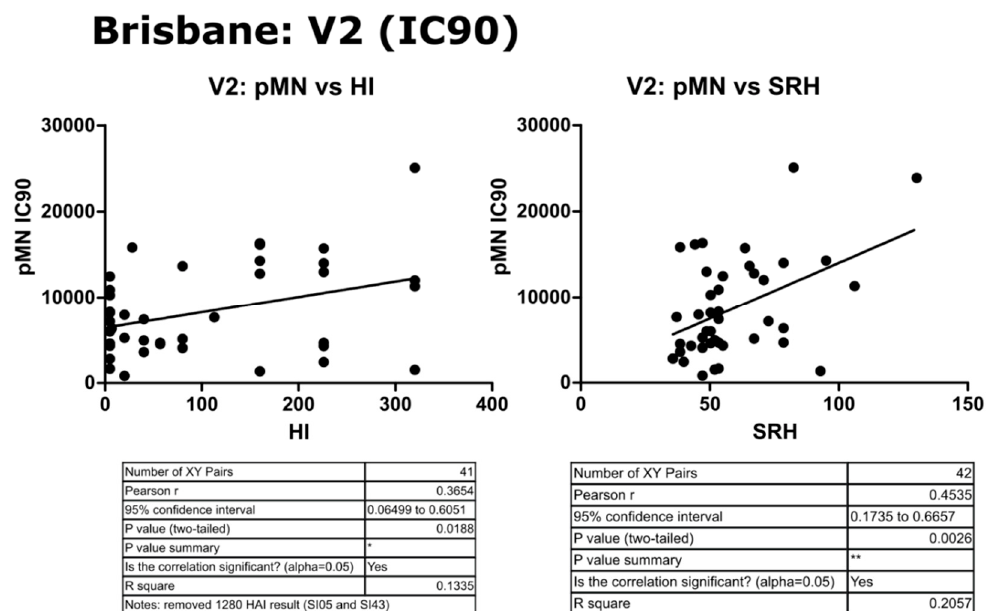
Figure 10. Correlation of pMN (IC 90 ) with HI and SRH using mean V2 values for sera assayed against B/Brisbane/60/2008 PV. Pearson’s two-tailed analysis performed using prism Graph Pad. Weak correlation was observed between IC 90 antibody titres and HI (Pearsons r = 0.36). IC 90 values correlated well with SRH values (Pearsons r = 0.45). p ≤ 0.05 = *, p ≤ 0.01 = **.